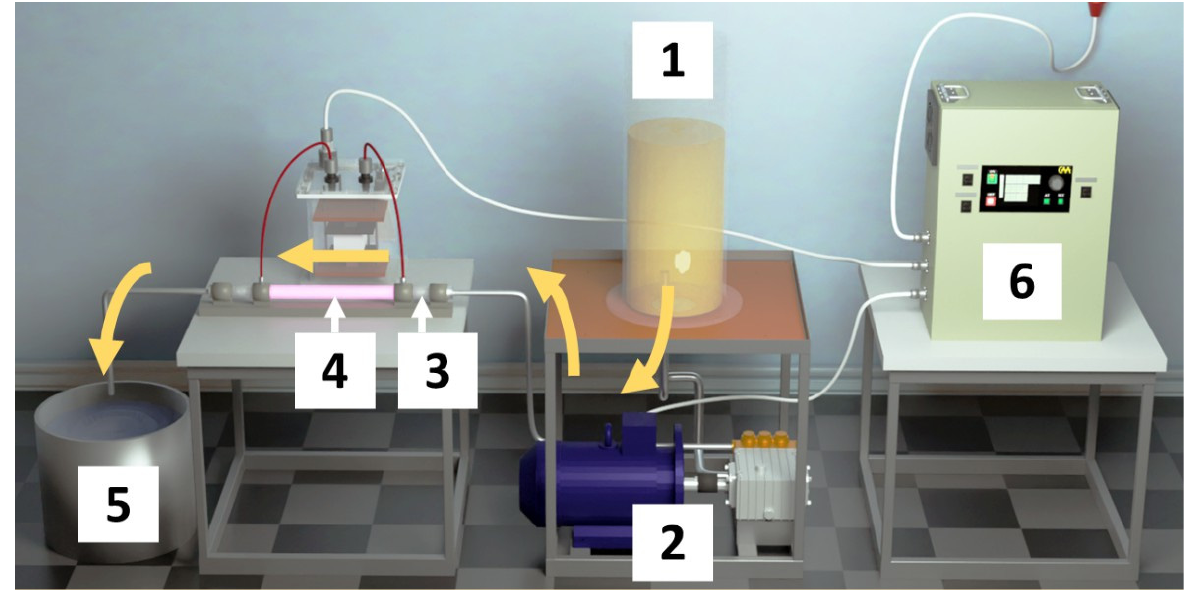
Figure 1. Laboratory flow reactor (1 m 3 /h) for sonoplasma wastewater treatment: ( 1 ) contaminated water tank (CeO 2 catalyst is added to the water); ( 2 ) high-pressure pump; ( 3 ) hydrodynamic emitter; ( 4 ) discharge camera; ( 5 ) treated water tank; ( 6 ) power supply.